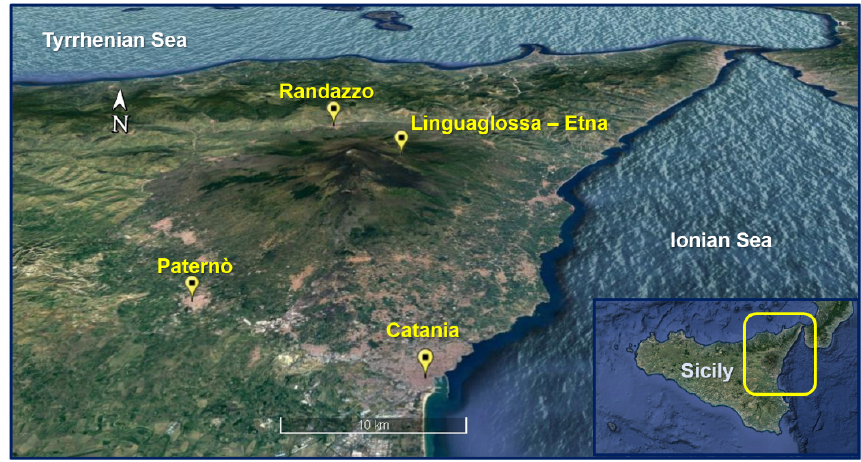
Figure 22. Map showing four weather stations on the eastern part of Sicily (edited from Google Earth). Figure 23 shows the accumulated precipitation values recorded by the selected meteo- rological stations. In particular, for the northwestern sector of Sicily, the greatest rainfall was recorded in Palermo (134 mm) and in Monreale (69 mm); the greatest rainfall accumulations in the eastern sector were recorded in Catania (49 mm) and in Paternò (37 mm).